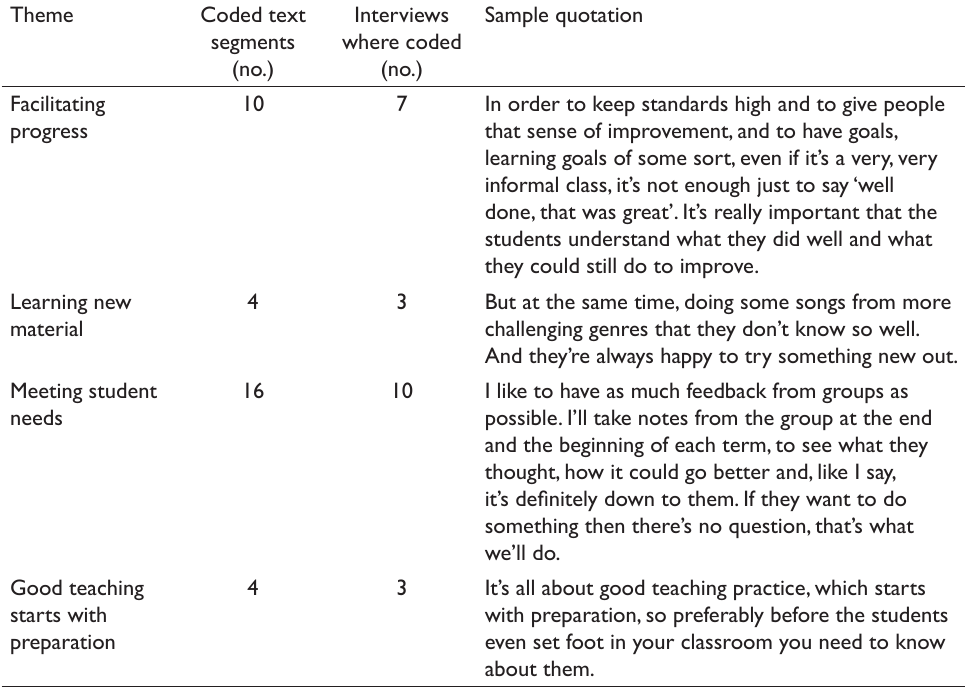
Table 3: Supporting matter-centred